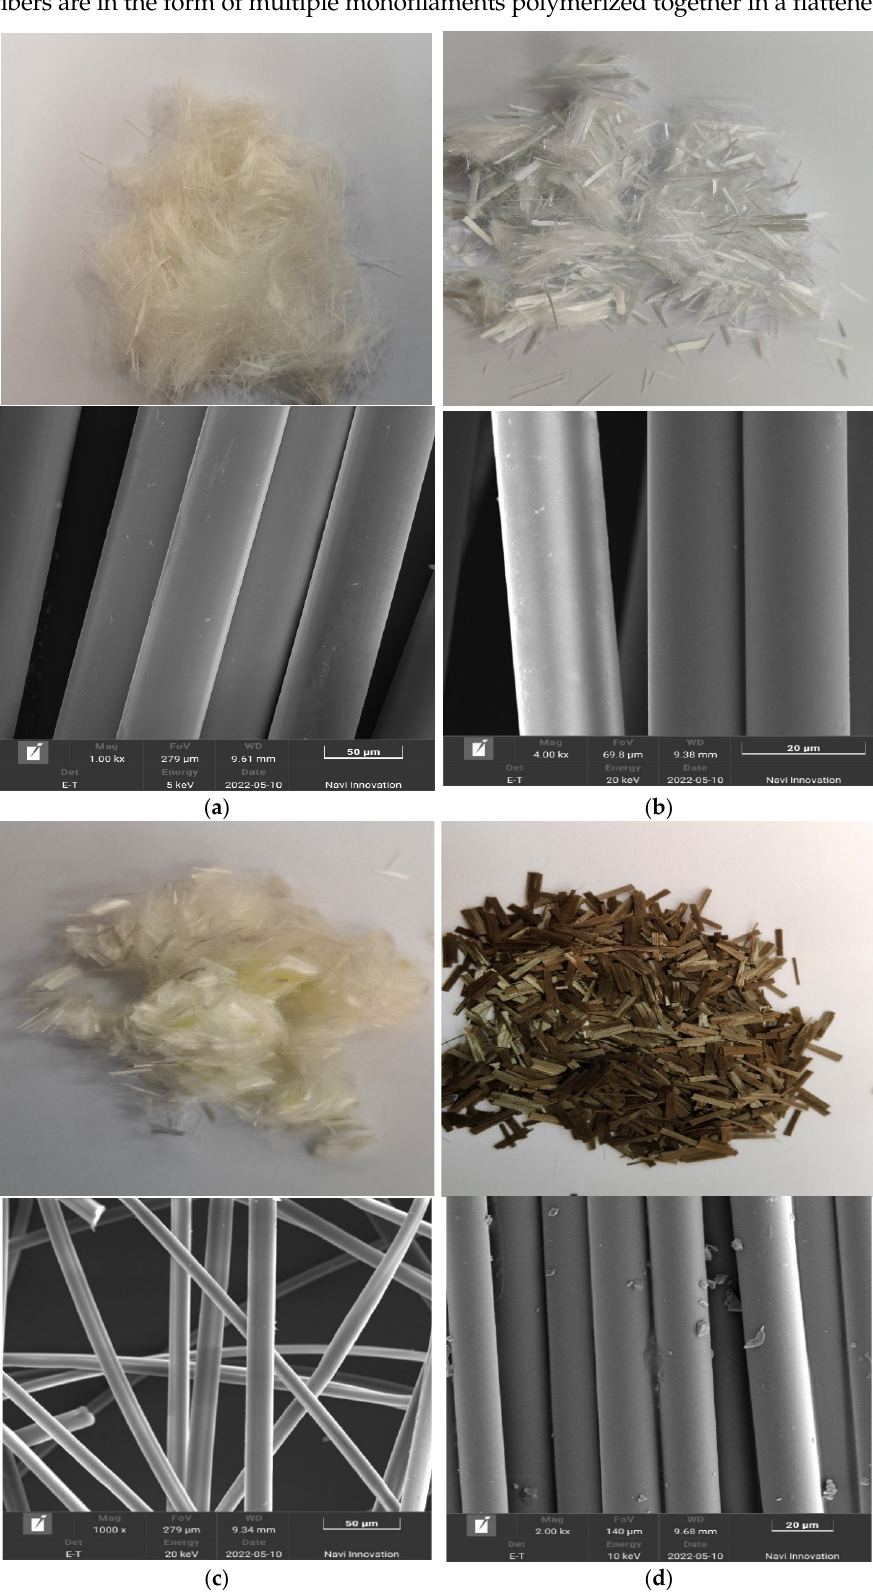
Figure 2. Physical and SEM micrographs of four fibers: ( a ) polypropylene fiber; ( b ) glass fiber; ( c ) polyvinyl alcohol fiber; ( d ) basalt